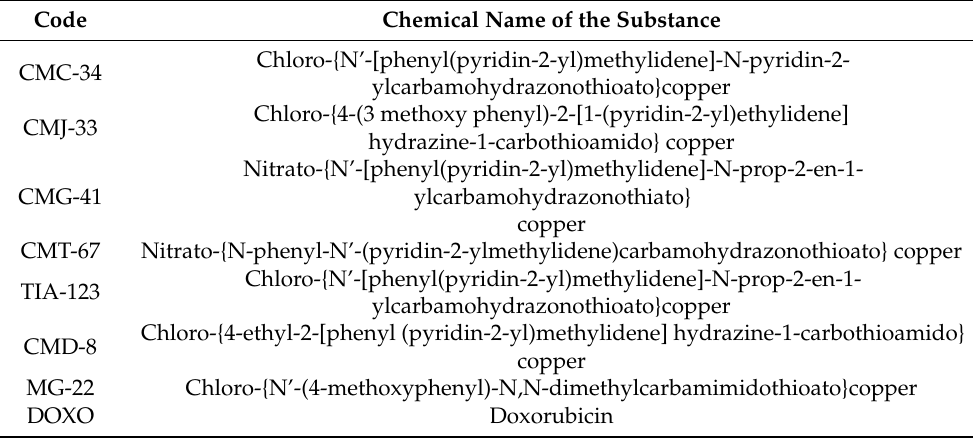
Table 1. The coordination compounds of thiosemicarbazide tested in the